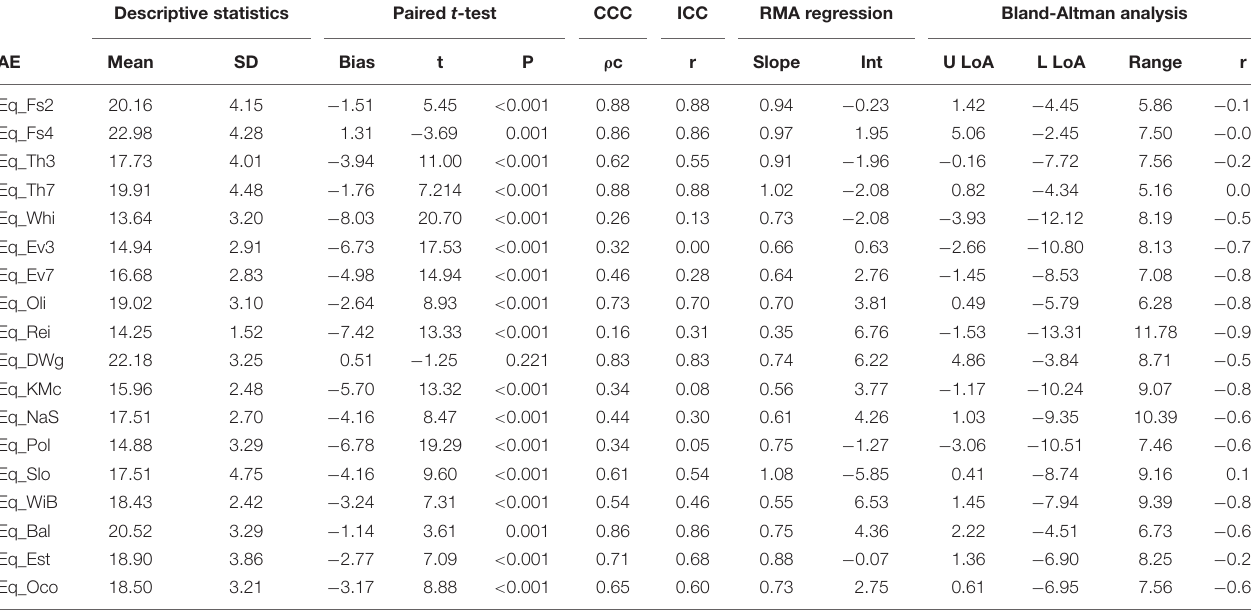
TABLE 3 | Analysis of the agreement between the percentage of fat mass obtained with anthropometric equations and the percentage of fat mass obtained by-means of